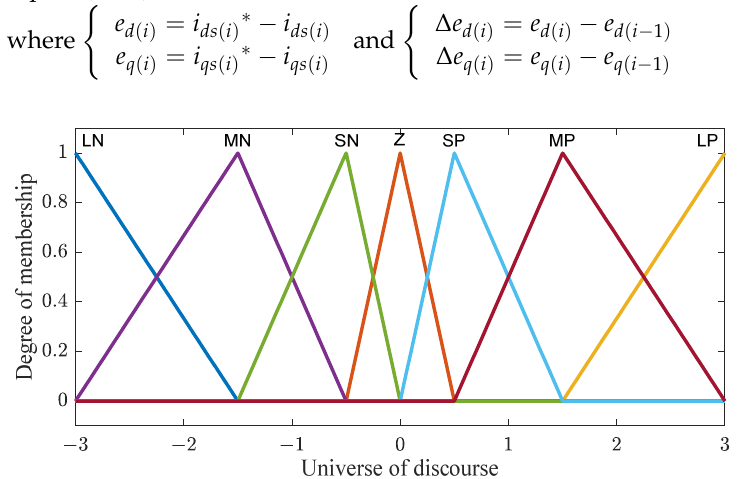
Figure 3. Fuzzy sets membership for inputs (e, ∆ e) and output ∆ U.